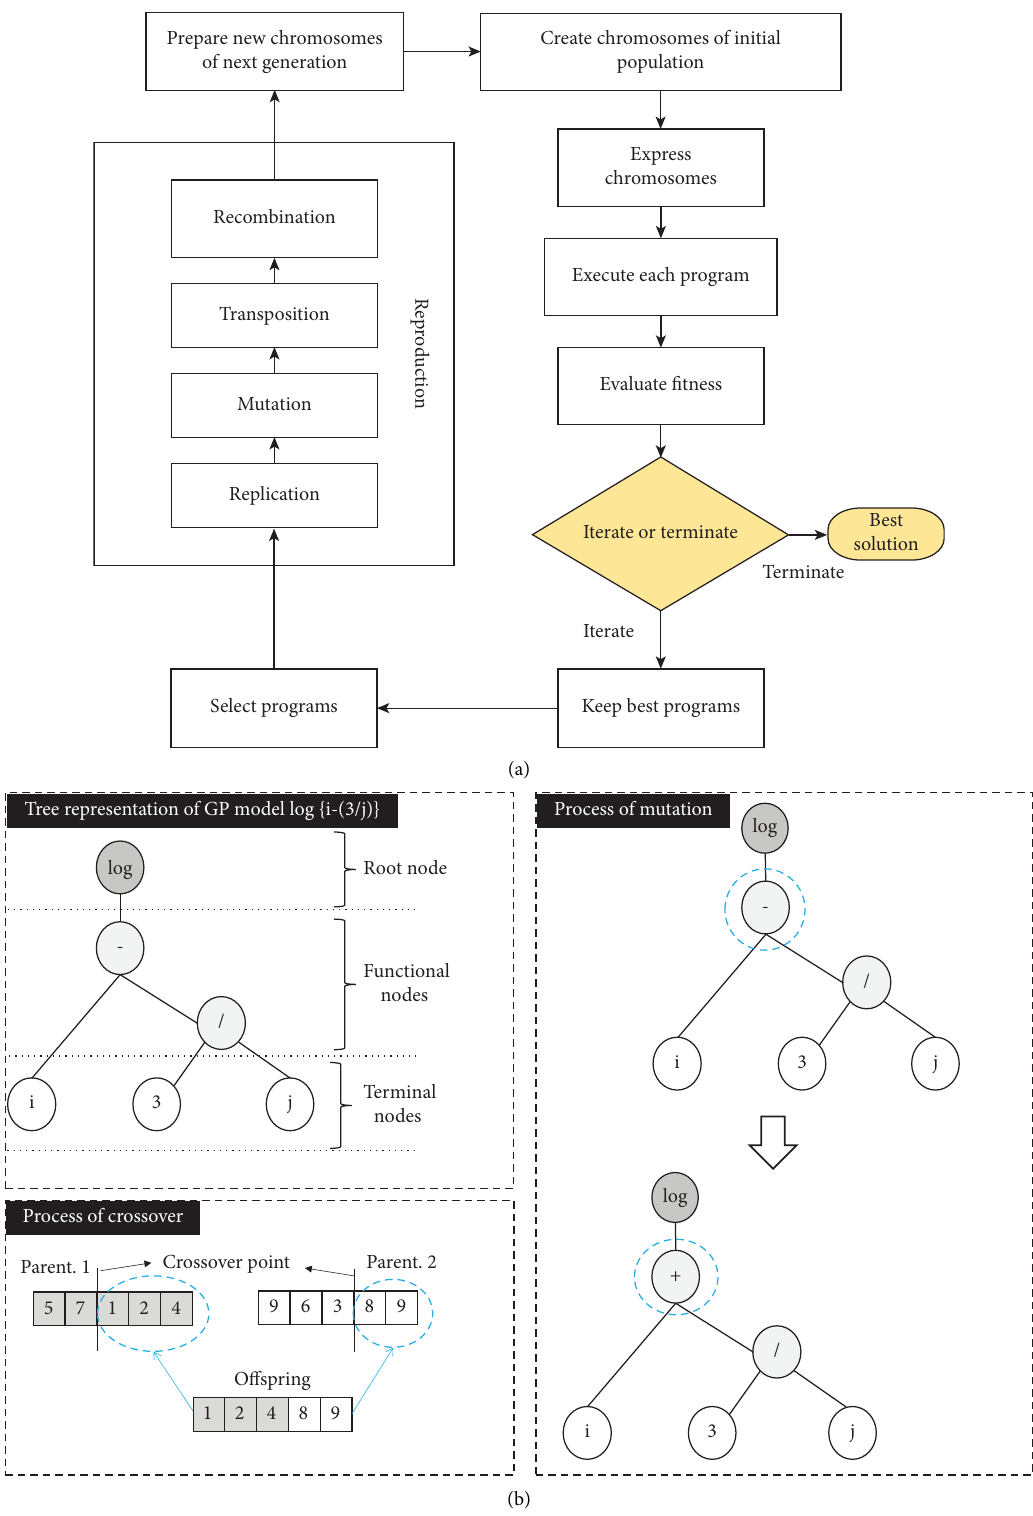
Figure 3: (a) Working mechanism of genetic programming approach (i.e., GEP) in the form of fowchart and (b) expression tree, crossover, and mutation processes in a typical GEP evolution progression [46,